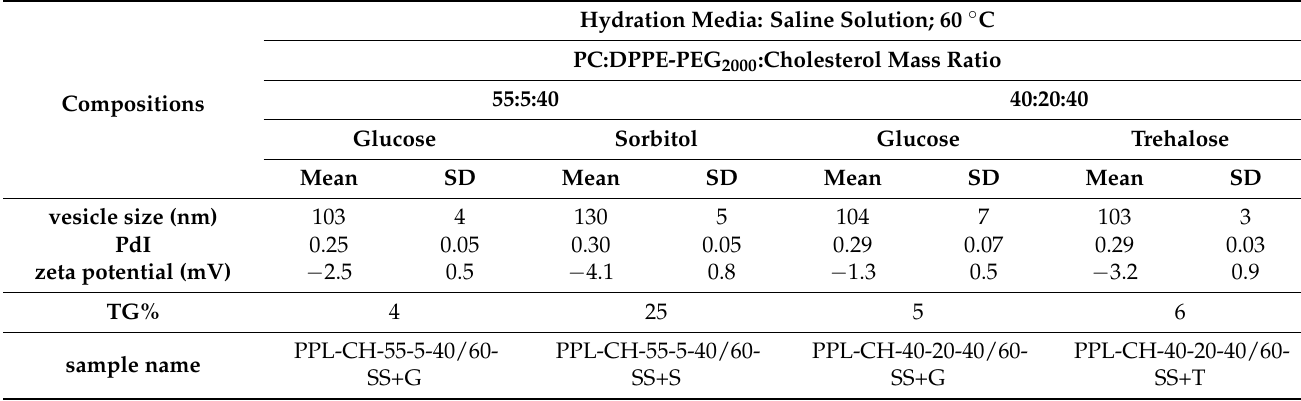
Table 12. Measurement results of the liposome samples lyophilised with different cryoprotectants prepared from PC-DPPE- PEG 2000 -CH 55:5:40 or 40:20:40 mass ratio composition at 60 ◦ C and hydrated with saline